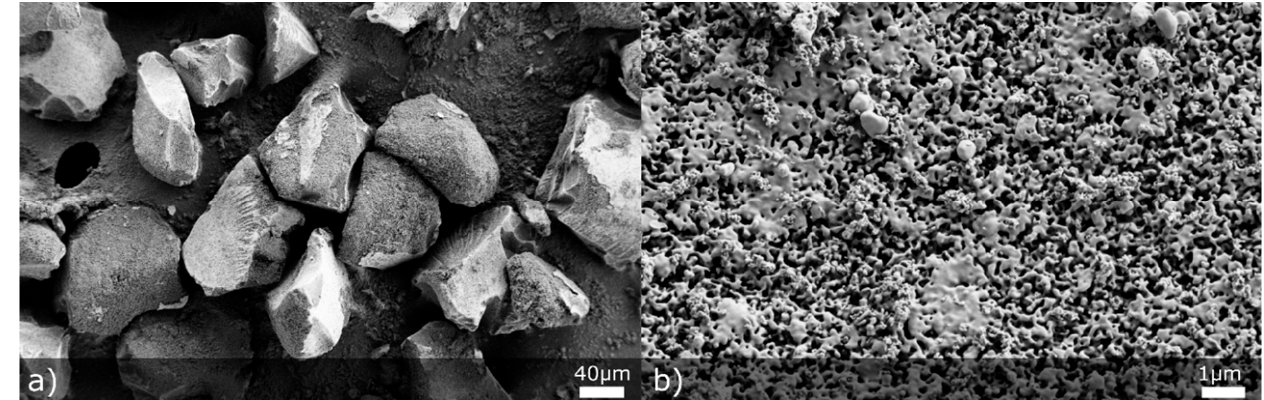
Figure 1. SEM pictures representing initial MS particles at ( a ) 500× and ( b ) 20,000× magnification.